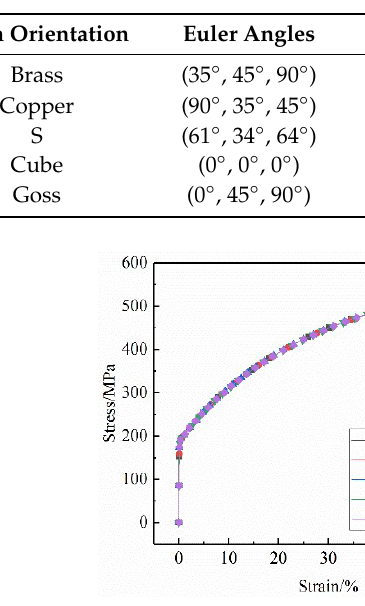
Figure 7. Stress–strain curves of G411 in the RVE model under five different grain orientations.